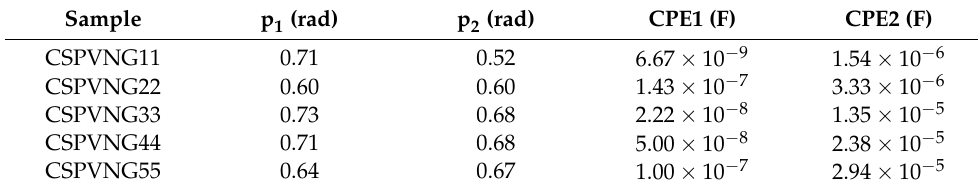
Table 3. Circuit elements of the plasticized PBE